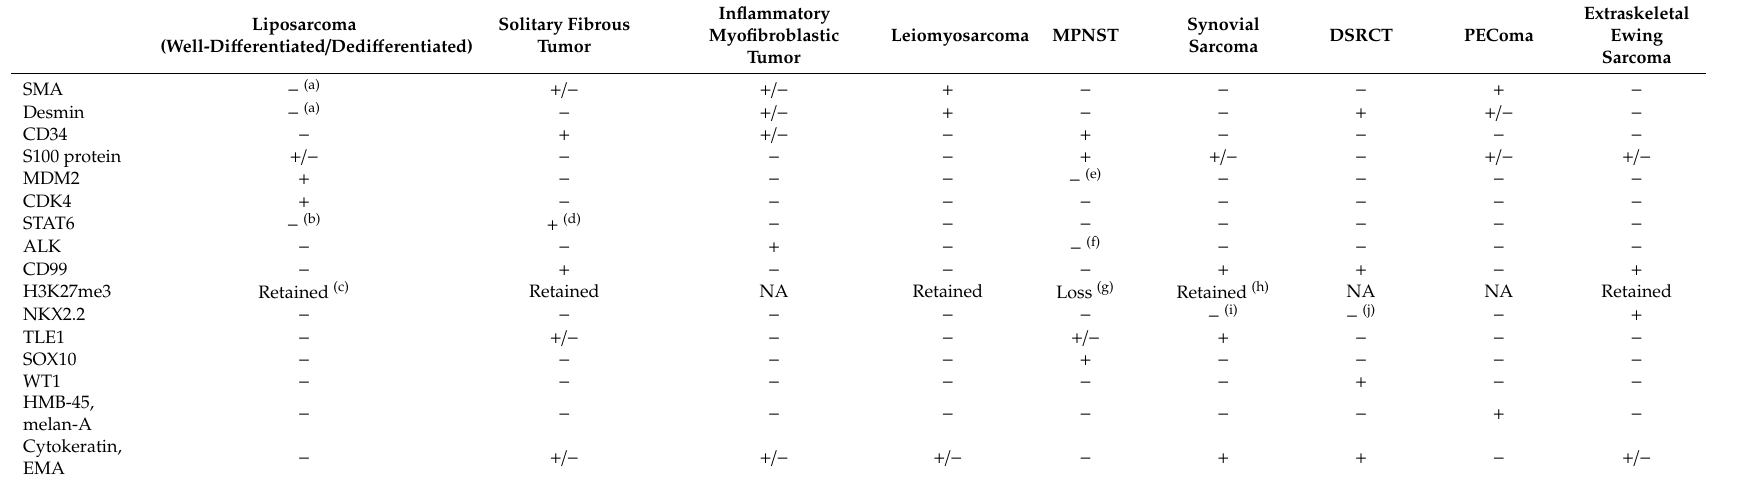
Table 3. Immunohistochemistry of selected retroperitoneal mesenchymal